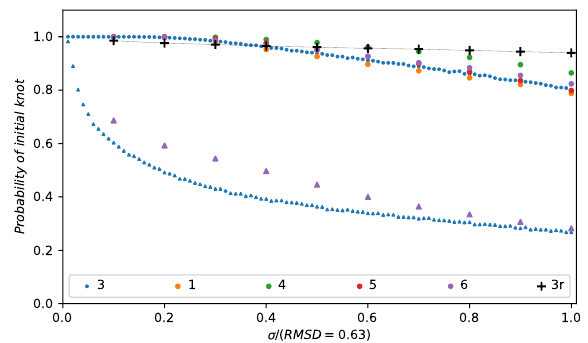
Figure 5. The stability of a knot against random displacements of its nodes. The probability of a change in topology for random displacements of all nodes belonging to the knots highlighted in Figure 4b is shown. The standard deviation of the random displacements increases on going to the right. While the red trefoil knot indicated by blue disks is stable for rather large displacements, the blue trefoil knot indicated by blue triangles is very unstable. Even small displacements are enough to change the topology. A very similar trend can be observed in model 6, which also exhibits a trefoil knot in the blue region (shown as purple triangles). As with model 3, small perturbations are sufficient to change the topology. All the models show a trefoil in the red region, though. The results for these knots are shown as circles. Here, all knots are stable against the displacements. Additionally, displacements of random regions are shown as black crosses with a connecting line as a guide for the eye (3r). These displacements also do not to change the